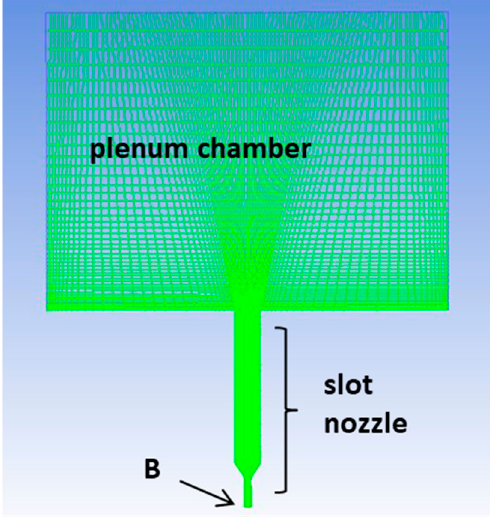
Figure 4. Calculation domain for the velocity profile slot jet generation.